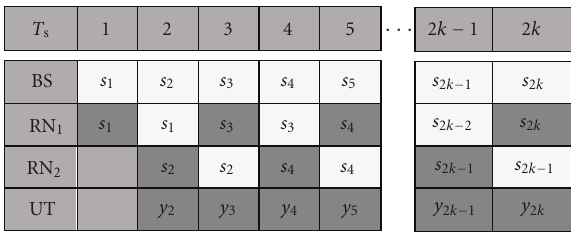
Figure 2: Transmitted (lighter cells) and received (darker cells) signals corresponding to each node of the RA K × 1 × 1 scheme with Precoded algorithm.